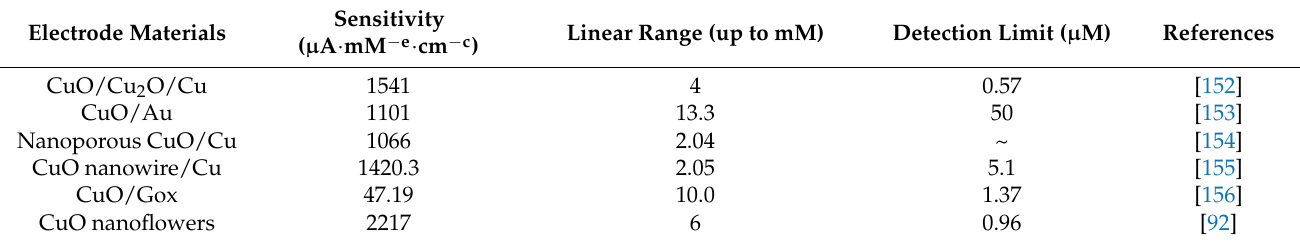
Table 1. Comparison of the performance of the CuO-nanoflower-modified electrode with those of the other reported glucose sensors. Reprinted with permission from Ref. [92]. Copyright 2018,